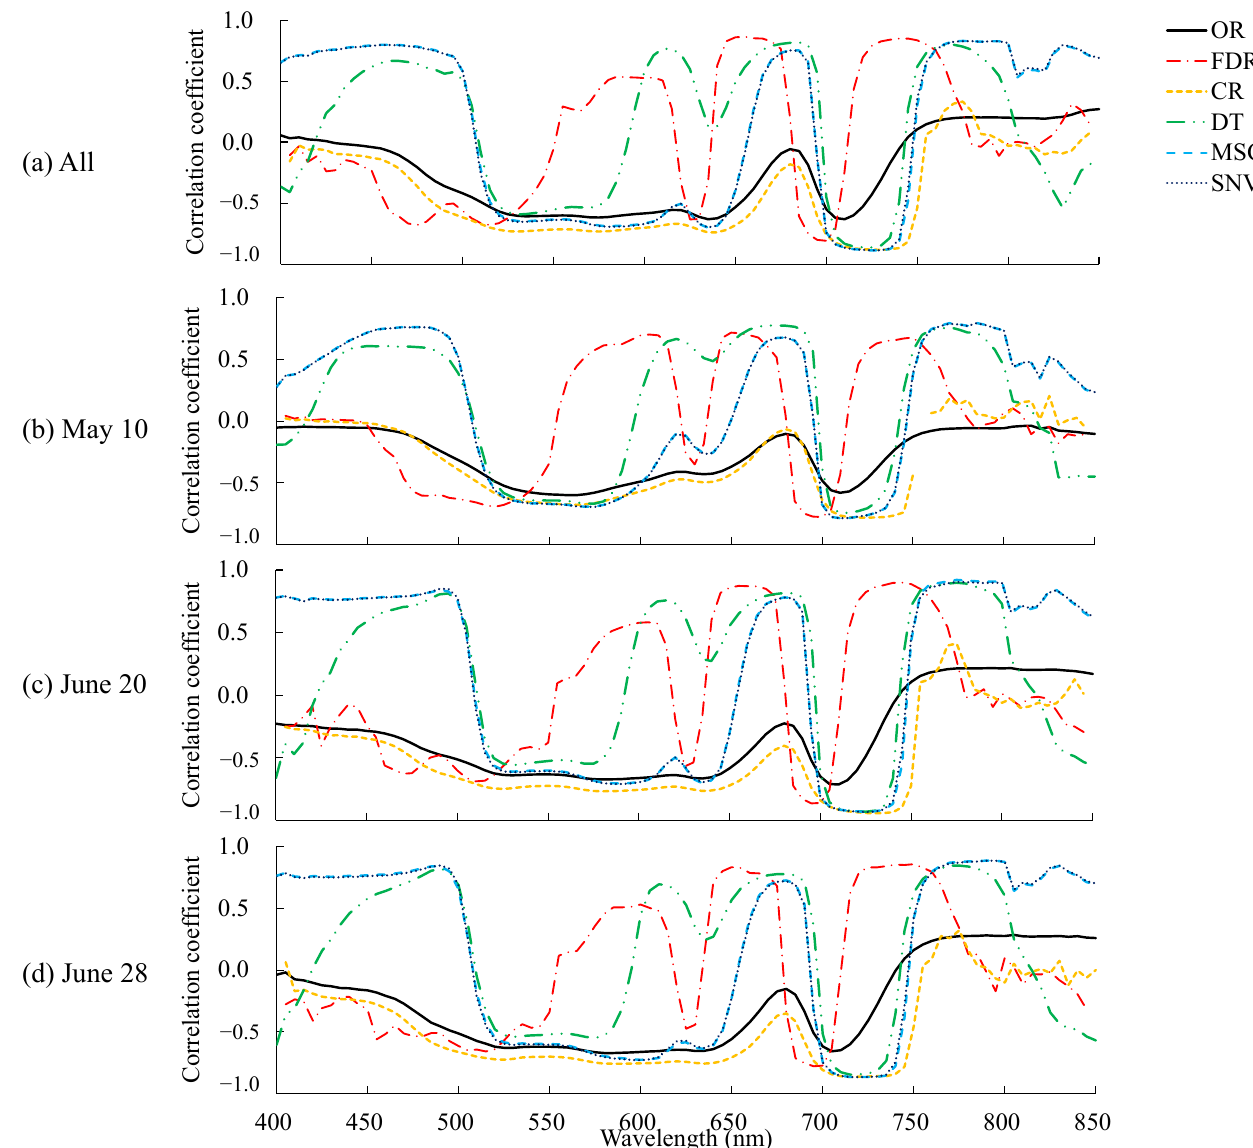
Figure 5. Correlations between chlorophyll content and a range of hyperspectral wavelengths when using various preprocessing techniques on the data.